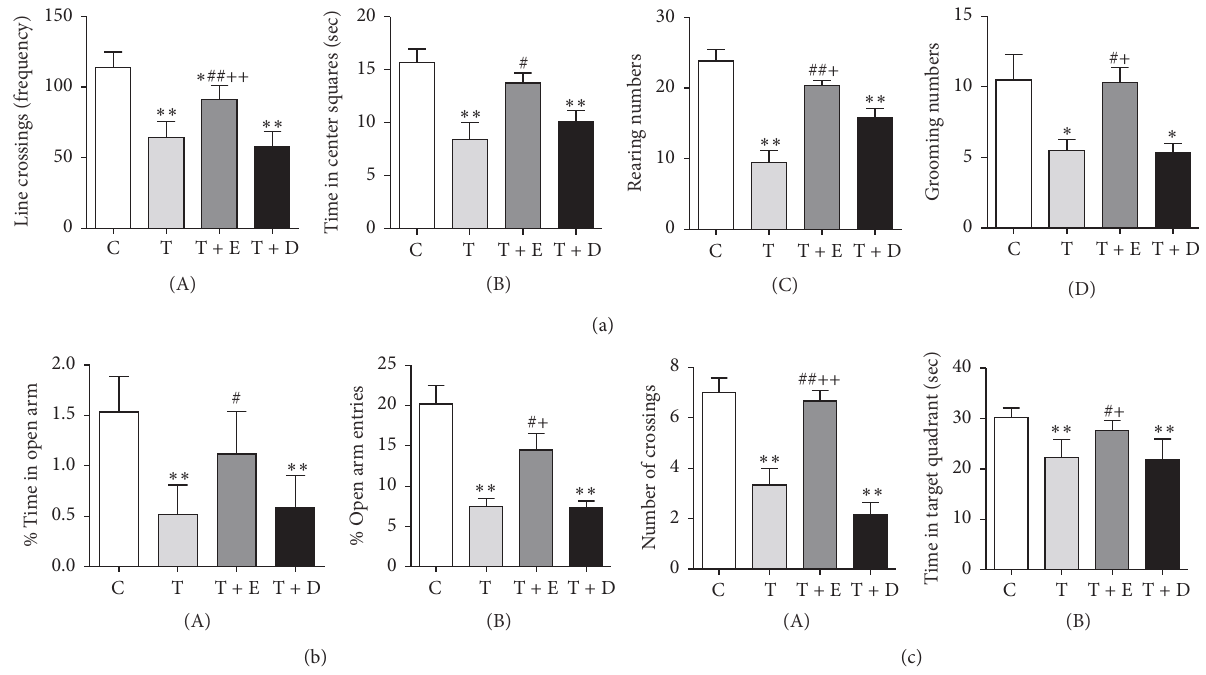
Figure 1: Anxiety-like behaviors and spatial memory performance. (a) Behavioral changes in the open-field test ( 𝑛 = 12 , per group): (A) frequency of line crossing, (B) time spent in central squares, (C) rearing times, and (D) grooming numbers. (b) Behavioral results in the elevated plus maze ( 𝑛 = 12 , per group): (A) percentage of time in open arm and (B) percentage of open arm entries. (c) Spatial memory performance in the Morris water maze ( 𝑛 = 12 , per group): (A) number of crossings in the target area and (B) time spent in the target quadrant. Values were expressed as mean ± SEM. ∗ 𝑝 < 0.05 and ∗∗ 𝑝 < 0.01 versus C group; # 𝑝 < 0.05 and ## 𝑝 < 0.01 versus T group; + 𝑝 < 0.05 and ++ 𝑝 < 0.01 versus T + D